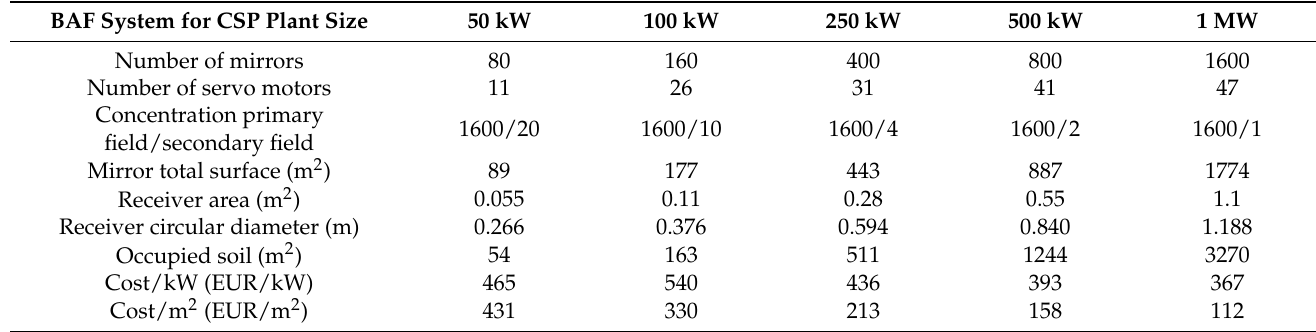
Table 2. Description of the main components of the BAF system for different plant